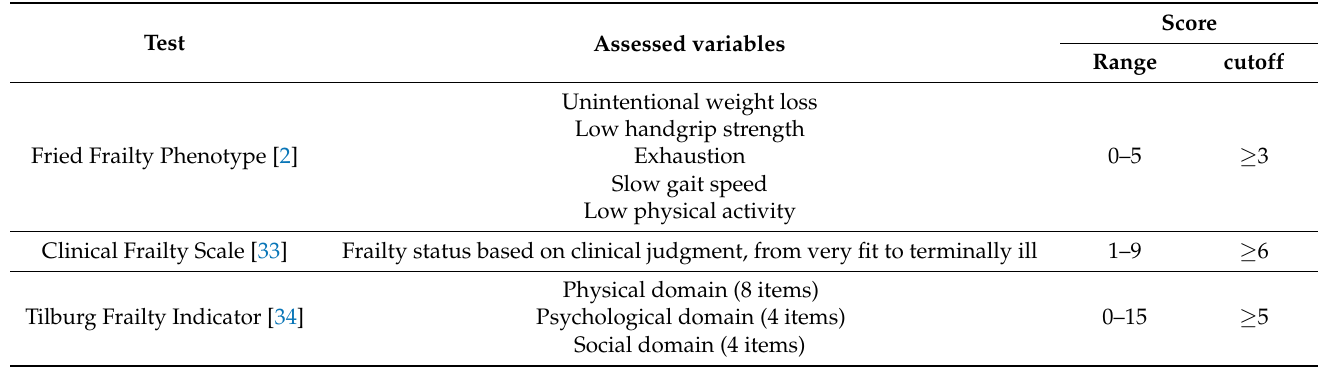
Table 1. Summary information about the Fried Frailty phenotype, the Clinical Frailty Scale, and the Tilburg Frailty